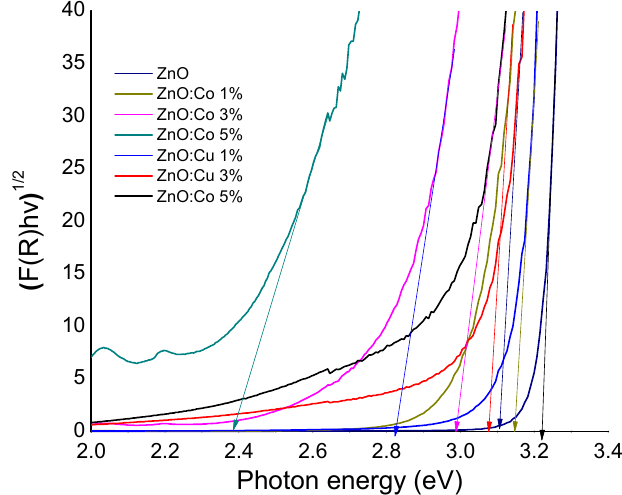
Figure 5. Kubelka–Munk (KM) fitting for the catalysts synthesized in this study. Figure 5. Kubelka – Munk (KM) fitting for the catalysts synthesized in this study. Table 2. Band gap and results of pseudo-first-order model